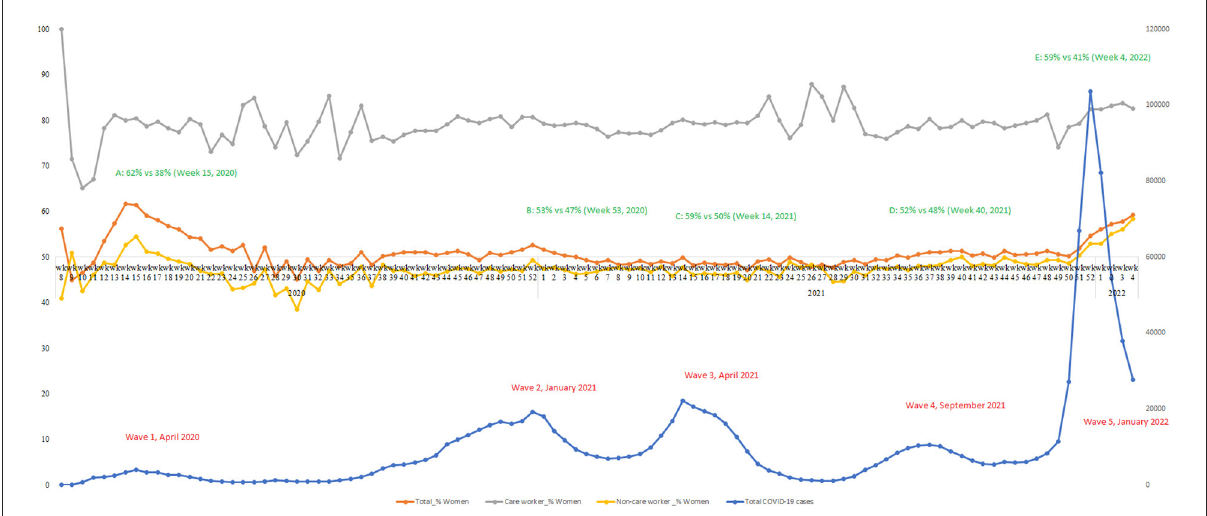
FIGURE3 Gender trajectories of relative COVID-19 infections in Canada,